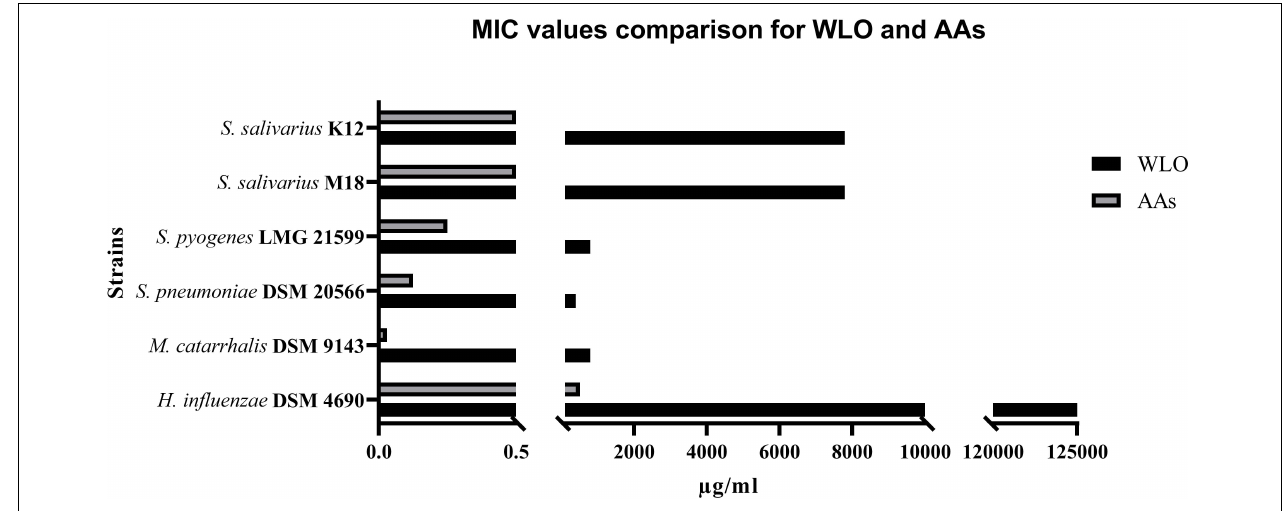
FIGURE 2 | Comparison between MIC values obtained for winterized lentisk oil (WLO) and anacardic acids (AAs) ( µ g/mL).